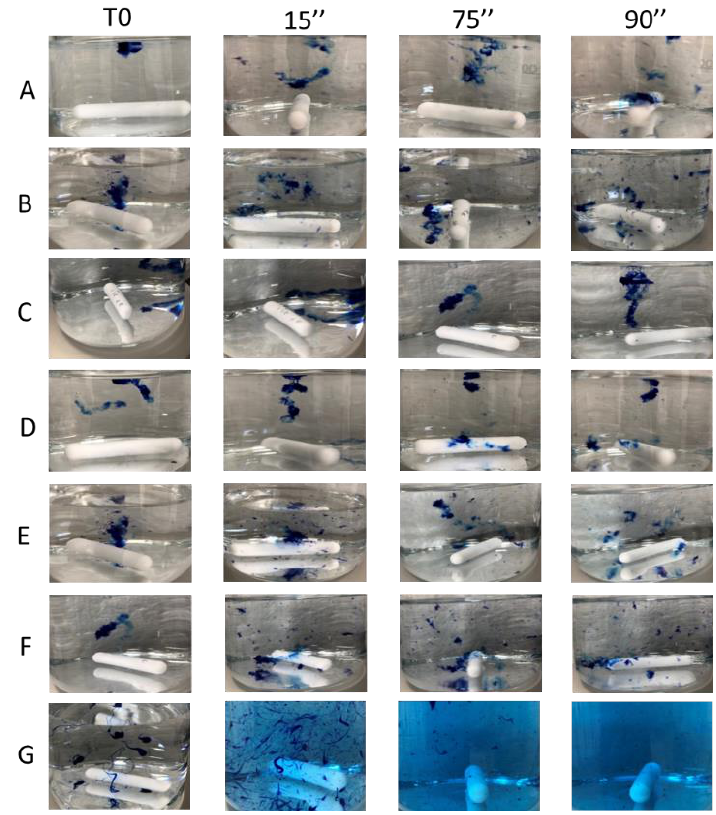
Figure 5. Cohesivity evaluation of six HA dermal fillers cross-linked with PEGDE and a HA hydrogel not cross-linked after staining with Toluidine Blue 1%. ( A ) HA hydrogel 22 mg/mL; ( B ) HA hydrogel 24 mg/mL ( C ) HA hydrogel 26 mg/mL LR; ( D ) HA hydrogel 26 mg/mL LV; ( E ) HA hydrogel 26 mg/mL with CaHA; ( F ) HA hydrogel 28 mg/mL; ( G ) HA non cross-linked hydrogel 18 mg/mL. The images of the gels were captured at extrusion time (T0) and after the conventional times of 15 s (15″), 75 s (75″) and 90 s (90″).